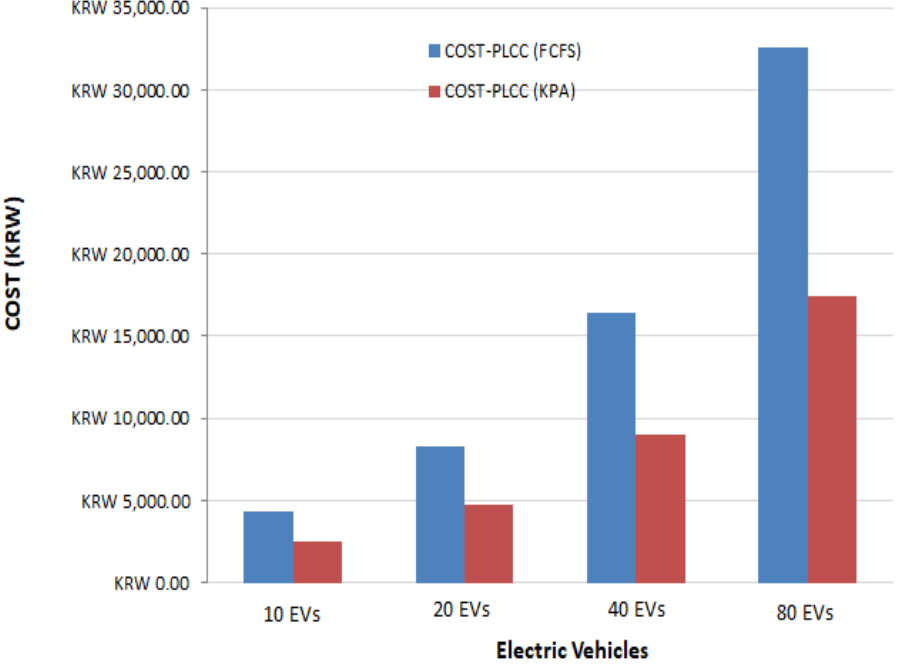
Figure 9. Average parking lot costs with different numbers of selling vehicles.